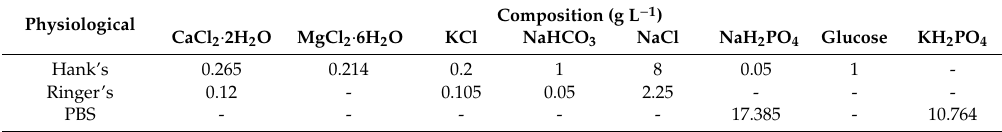
Table 1. Composition of the physiological solutions used in the corrosion